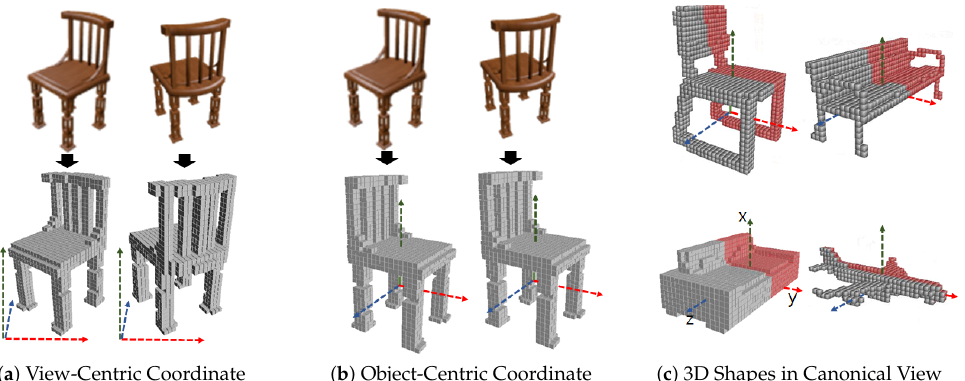
Figure 1. ( a ) View-centric coordinate where 3D shapes are aligned to input image view in 3D camera space. ( b ) Object-centric coordinate where 3D shapes are aligned to common canonical view regardless of views of input images. ( c ) In canonical view, all 3D shapes are aligned in world 3D space. Objects are symmetric with respect to the x-y plane (symmetry